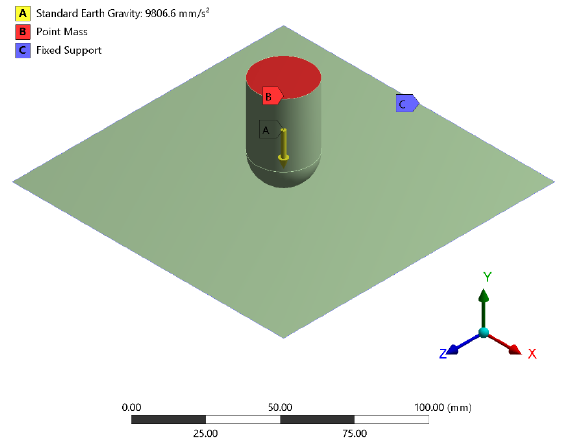
Figure 12. Loading and boundary conditions. Table 8. Mesh convergence check for 20 J case.